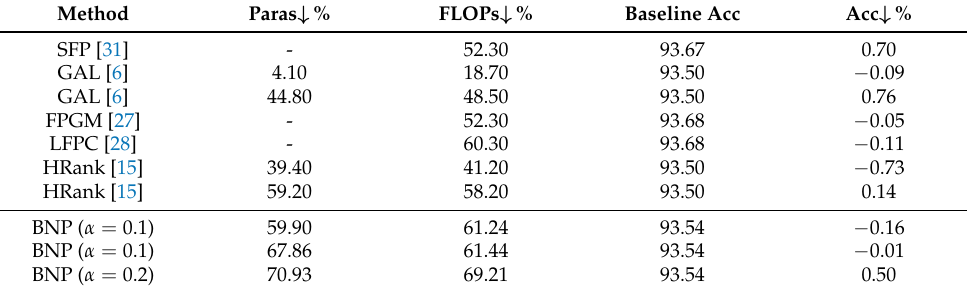
Table 3. Network pruning results of ResNet-110 on